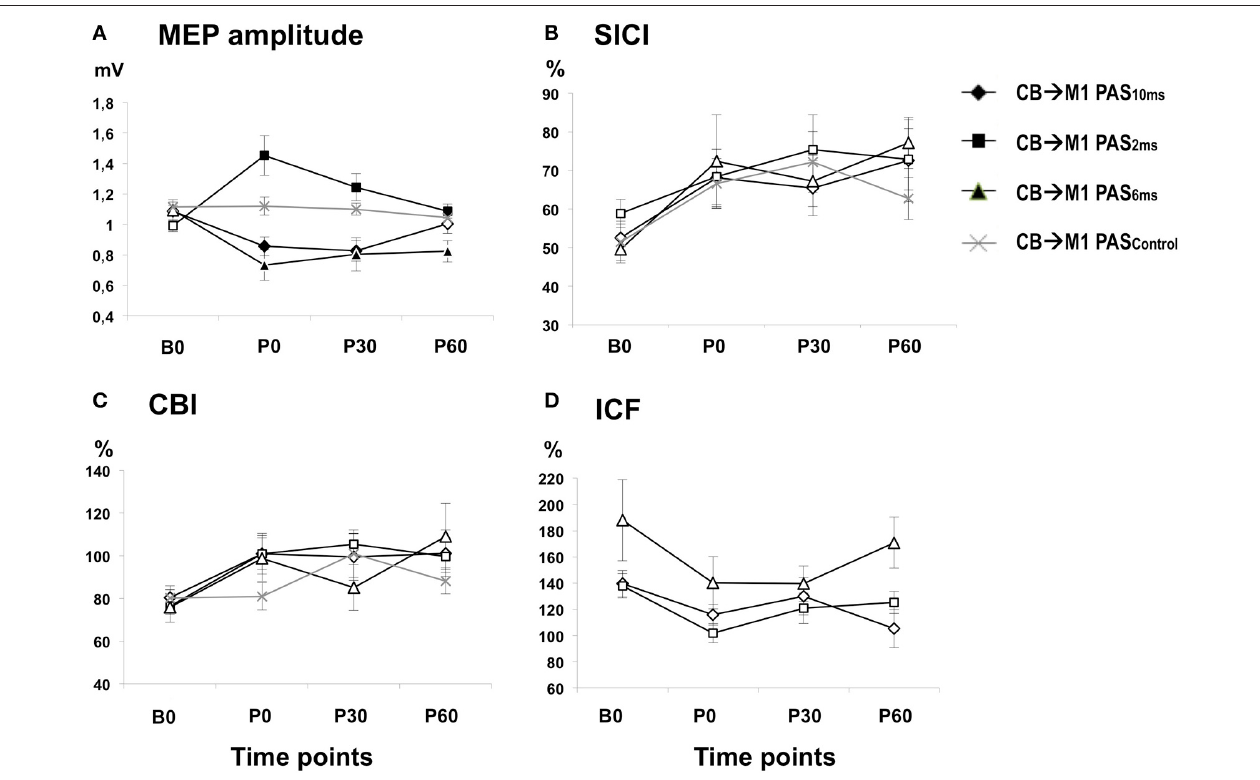
FIGURE 3 | (A) Means ( ± SEM) of MEP amplitude (in mV) at baseline (B0), immediately (P0), 30min (P30) and 60min (P60) after CB → M1 PAS (rhomboids: CB → M1 PAS 10ms ; triangles: CB → M1 PAS 6ms ; squares: CB → M1 PAS 2ms ; crosses: CB → M1 PAS Control ). Filled symbols denote significant differences in MEP amplitude after CB → M1 PAS compared to B0. Note significant MEP suppression at P0 and P30 after CB → M1 PAS 10ms and at P0–P60 after CB → M1 PAS 6ms but MEP potentiation at P0–P60 after CB → M1 PAS 2ms . In contrast, MEP amplitude remained